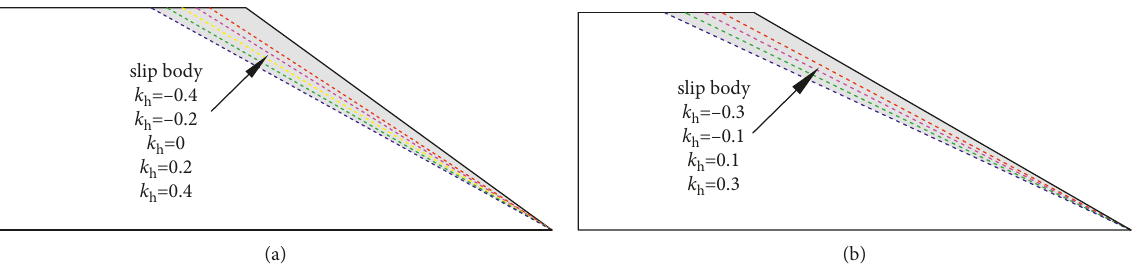
Figure 12: Slip body state under earthquake action. (a) Result of case 1. (b) Result of case